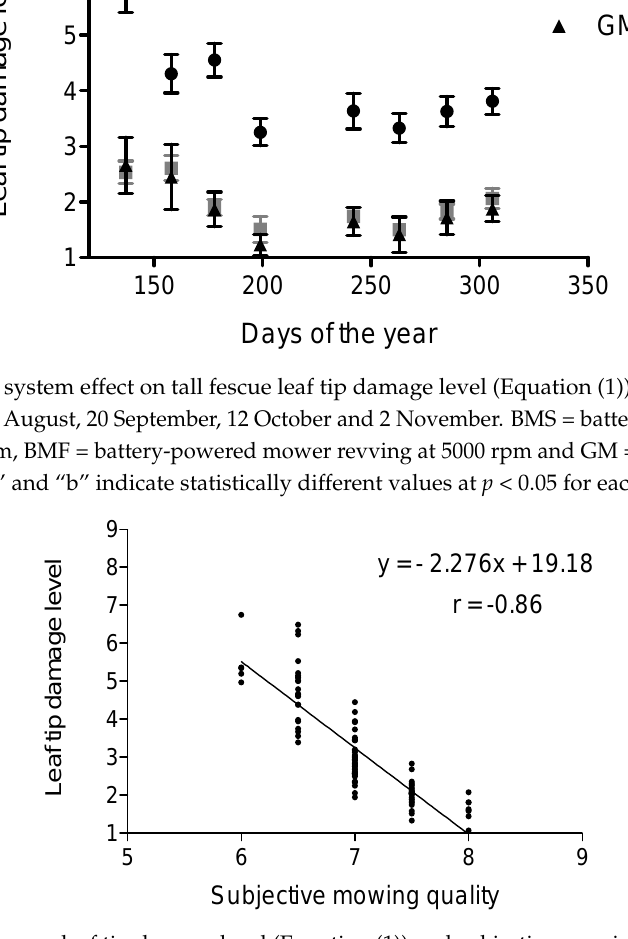
Figure 7. Bermudagrass leaf tip damage level (Equation (1)) and subjective mowing quality (1 = poor, 9 = excellent) correlation and Pearson’s correlation coefficien t (r). All replicates are reported.